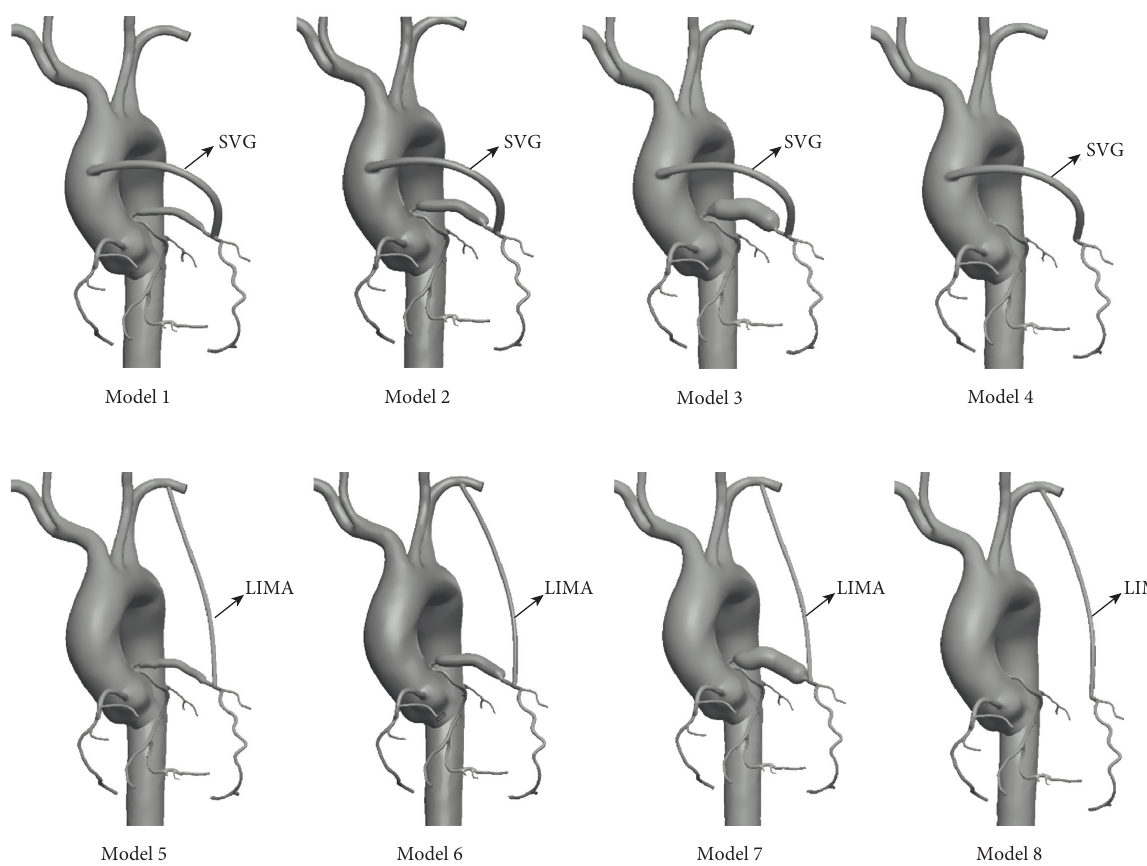
Figure 1: All eight 3D CABG surgery models which describe the location and the size of the CAA and the way of how to perform the bypass surgery. Models 1–4: bypass graft is SVG and the diameter of CAA is 2x, 3x, 5x, and 0 (CAA ligated), separately. Models 5–8: bypass graft is LIMA and the diameter of CAA is 2x, 3x, 5x, and 0 (CAA ligated), separately. Table 1: The results of the mesh independency test on WSS and